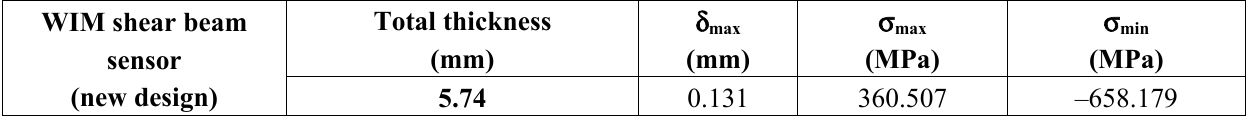
Table 3. Maximum stress, minimum stress and maximum displacement of the central plate (asymmetric loading case, Sandvic 7C27M02 steel type).